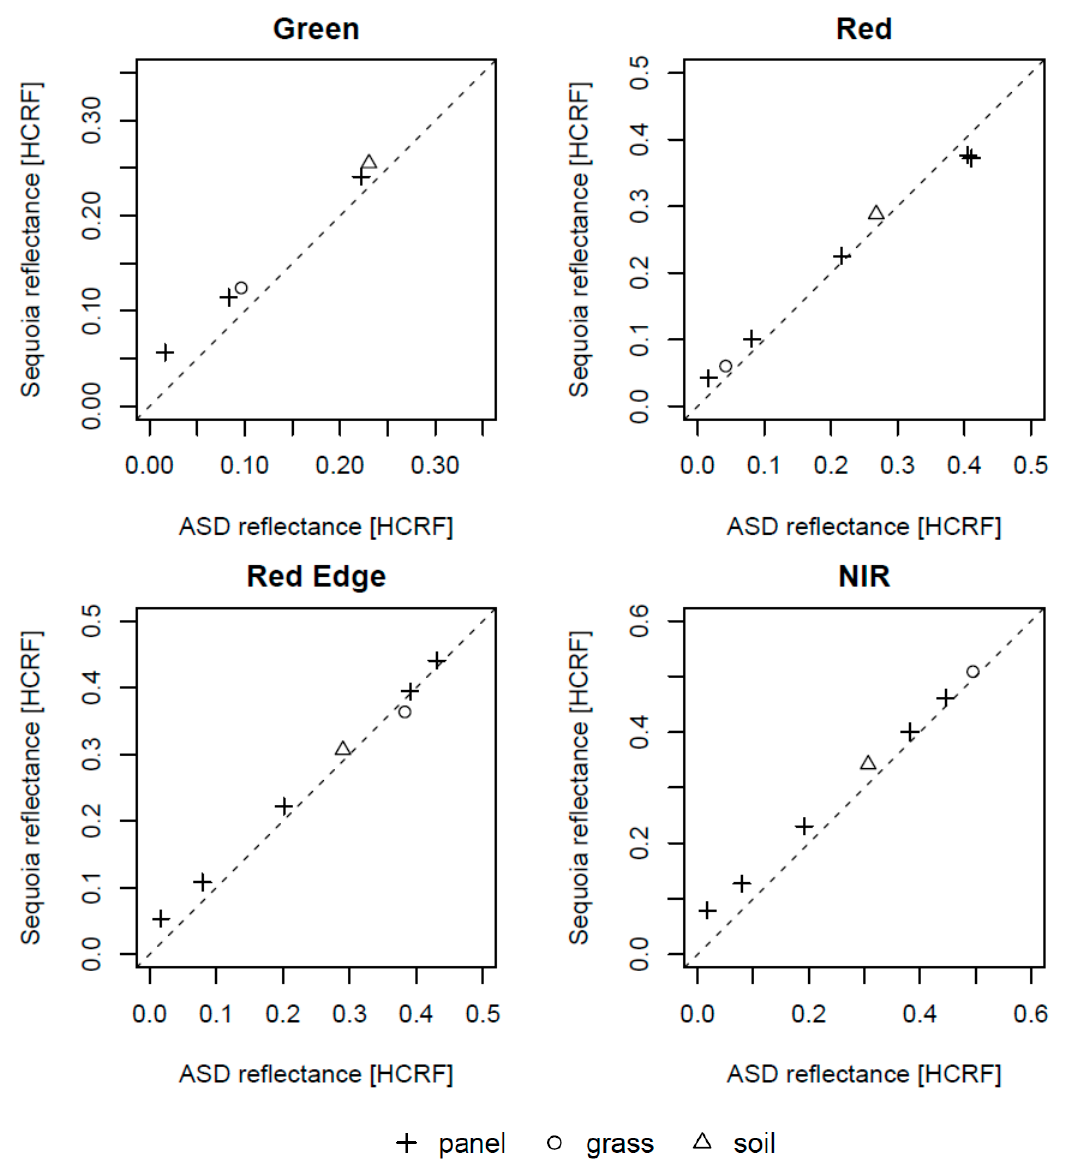
Figure 6. Sequoia multispectral image data-derived HCRF of validation targets compared to ASD measurements. Table 2. Mean absolute deviation (MAD) of Sequoia derived HCRF values per band for the three calibration approaches, estimated from the comparison with field measured reference panels and surfaces.